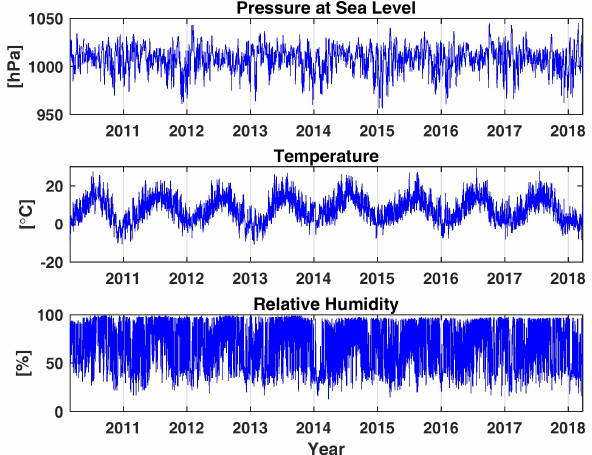
Figure 10. Meteorological data showing pressure, temperature, and relative humidity from March 2010 to March 2018. The meteorological data are from The Norwegian Meteorological Institute’s measurement station in Tafjord, located approximately 8.5 km from the radar.